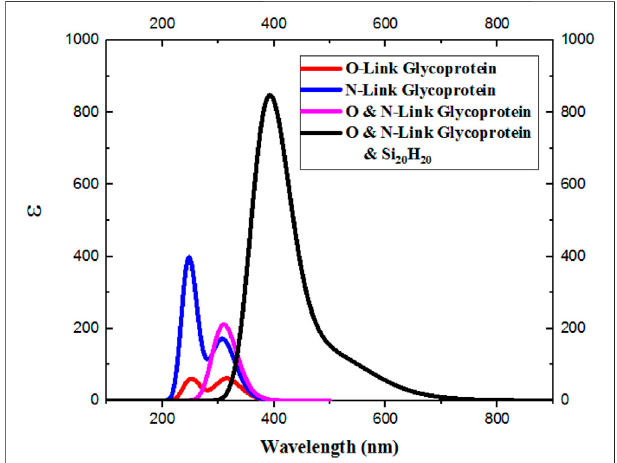
FIGURE 8 | The distance between the two structures of sila- dodecahedrane and glycoprotein in four zones that have intermolecular interaction.